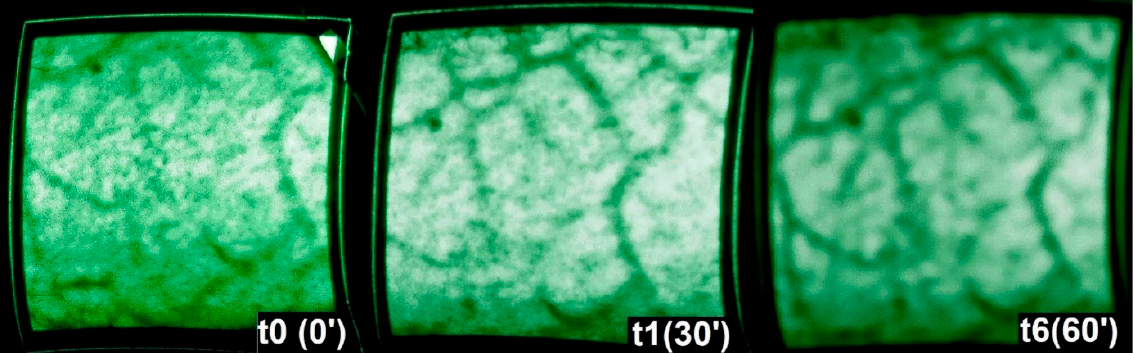
Figure 8. Vein illuminator images, showing patterns of superficial veins, captured by a digital camera at t0 (0’) ( left ), t1 (30’) ( middle ), and t6 (60’) ( right ).